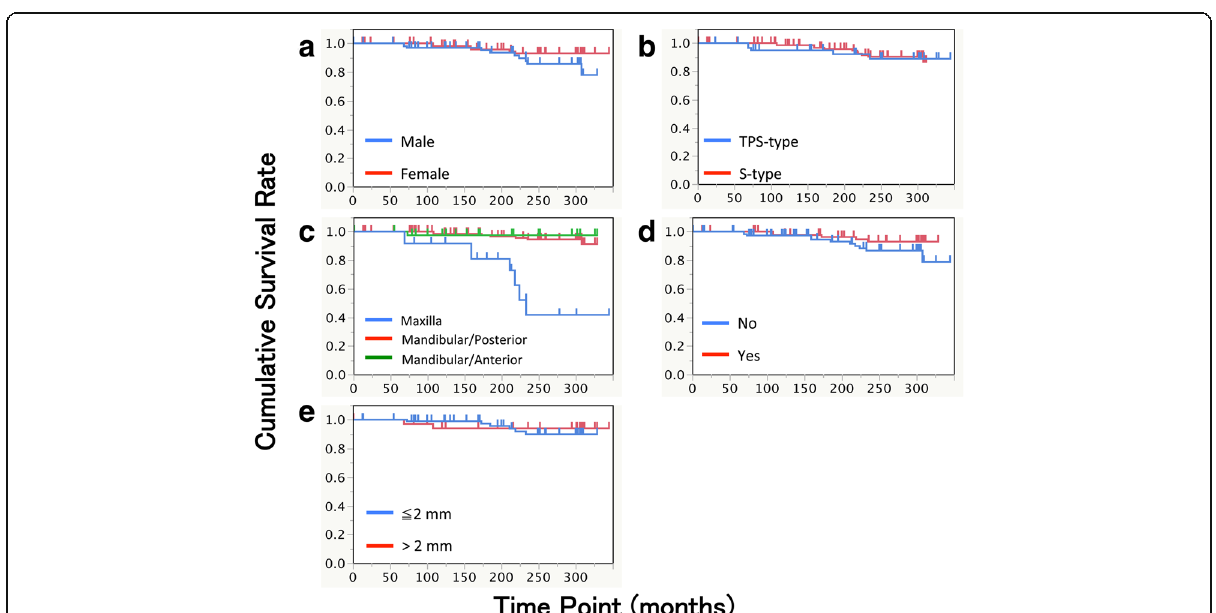
Fig. 2 Kaplan-Meier cumulative survival rates by a gender ( p = 0.1049), b implant type ( p = 0.6259), c implant position ( p < 0.0001), d presence of additional soft tissue management ( p = 0.1149), and e width of keratinized mucosa around implant ( p = 0.7132). Log rank test was used for